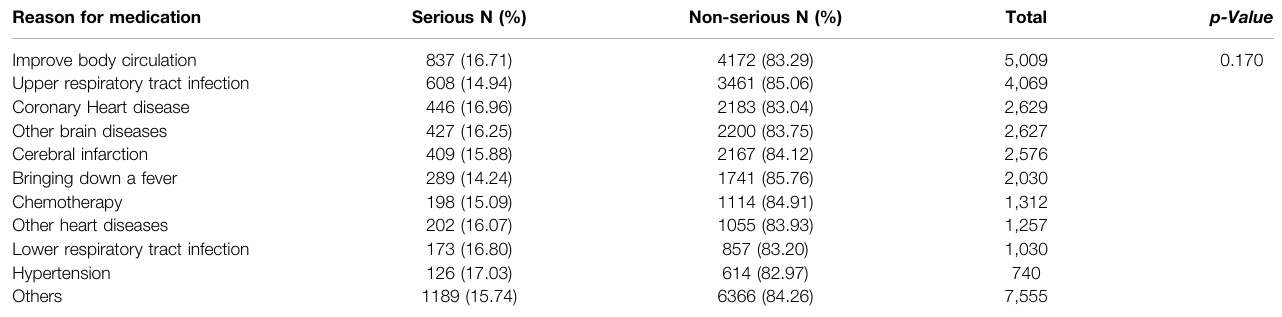
TABLE 3 | Number and proportion of serious and non-serious reports by Reason for medication. Reason for medication Improve body circulation